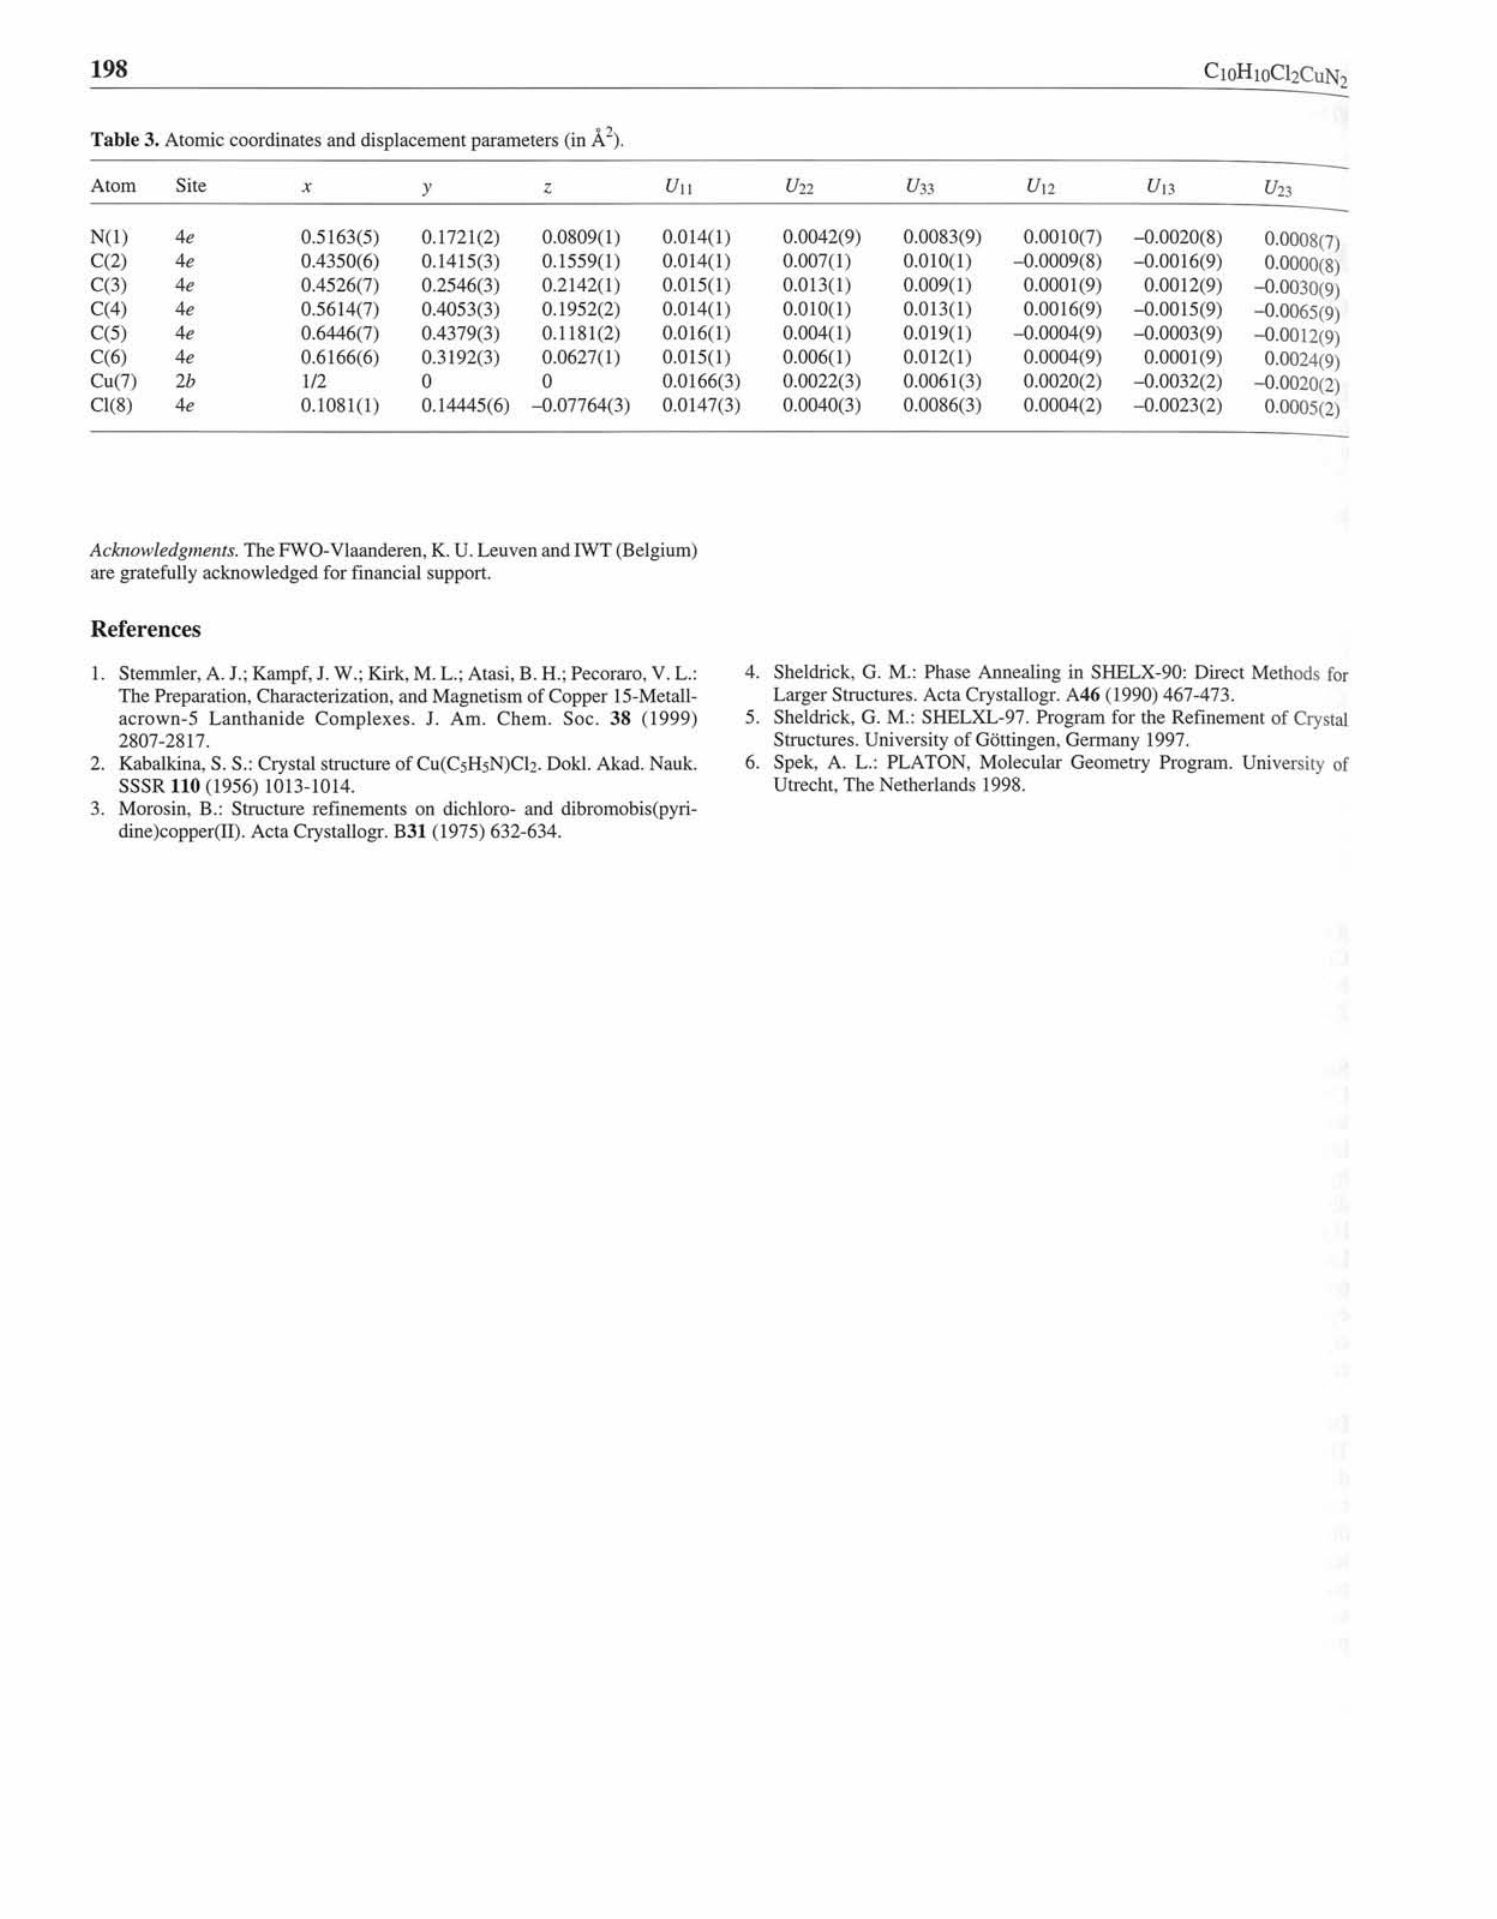
Table 3. Atomic coordinates and displacement parameters (in Â 2